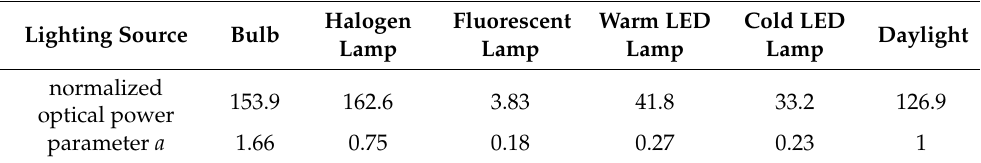
Table 2. The values of the normalized power produced by the solar cell at irradiation from the tested light sources and values of parameter a . Lighting Source